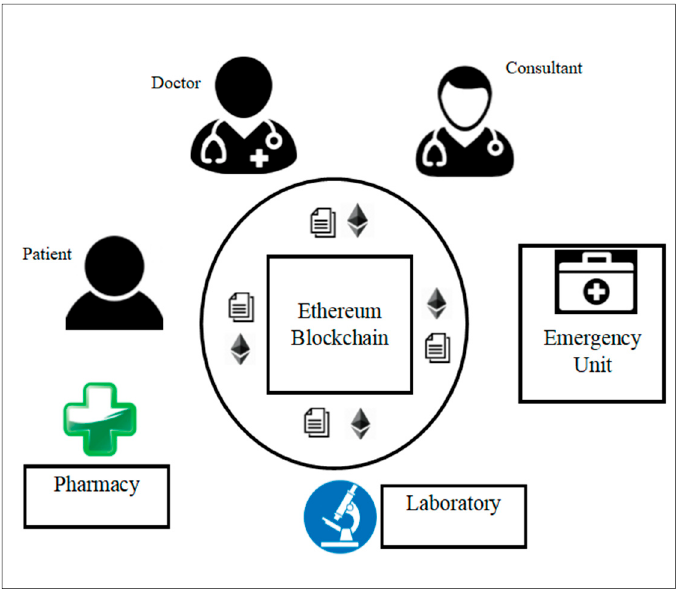
Figure 4. Smart contract for sharing lab results.